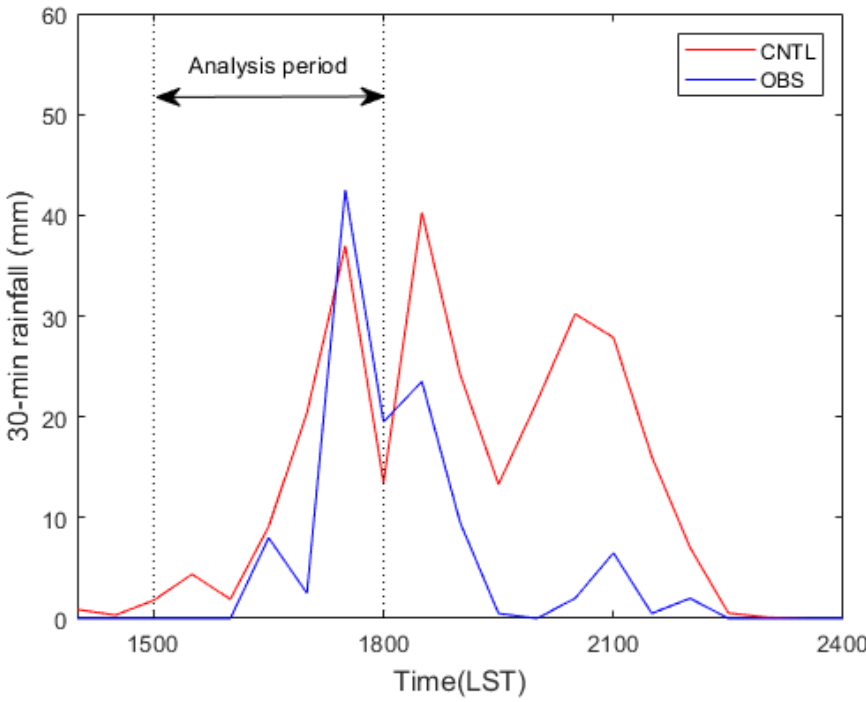
Figure 6. The time series of peak rain rates in the analysis domain in CNTL and observation (OBS) from 1400 to 2400 LST on 6 July 2017.